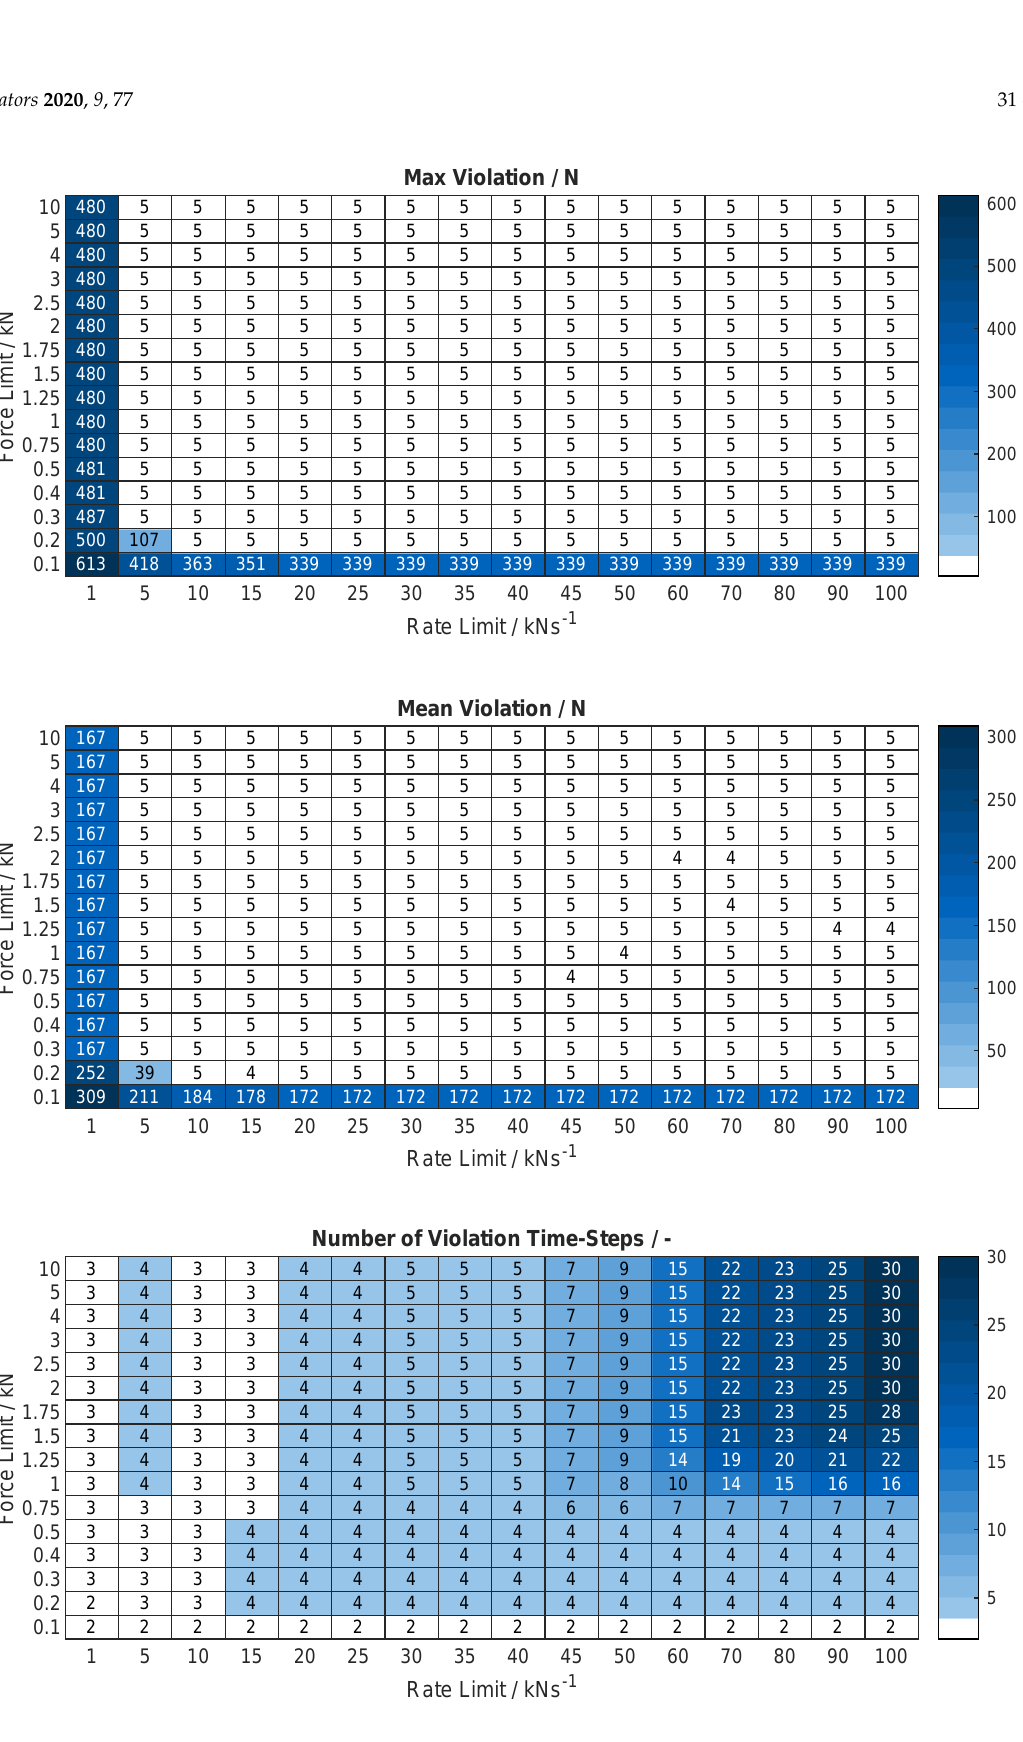
Figure A16. Dynamic wheel-load constraint violations in the 180kmh − 1 AB profile